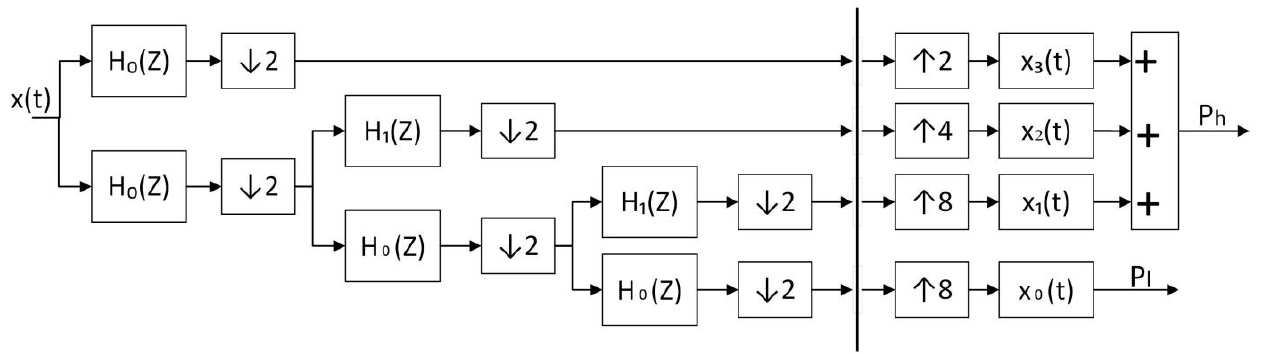
Figure 3. Power signal decomposition and reconstruction.